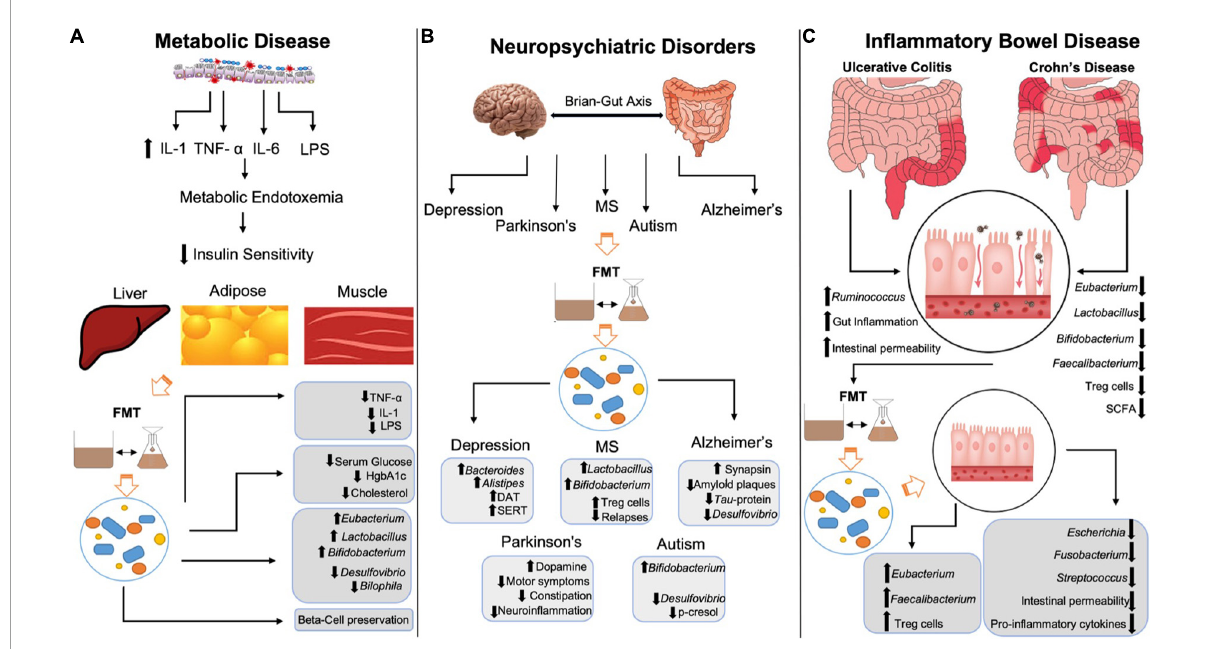
FIGURE1 Mechanisms by which FMT restores negative changes in metabolic disease, neuropsychiatric conditions and inflammatory bowel disease. (A) LPS-mediated increases in IL-1, TNF- α , and IL-6 leads to metabolic endotoxemia decreasing insulin sensitivity in liver, adipose, and muscle tissue. FMT reduces LPS, IL-1 and TNF- α , lowers serum glucose, HgbA1c and cholesterol levels and preserves beta-cells in T1DM patients. FMT increases Eubacterium, Lactobacillus, and Bifidobacterium spp., while reducing Desulfovibrio and Bilophila spp. (B) FMT increases dopamine transporter and serotonin transporter expression, while also increasing Bacteroides and Alistipes in patients in depression. FMT increase Lactobacillus, Bifidobacterium and Treg activity in multiple sclerosis patients, while reducing relapses/flares. FMT increases synapsin, amyloid plaques and Tau-protein phosphorylation in Alzheimer’s disease while reducing Desulfovibrio spp. FMT increases dopamine while decreasing neuroinflammation, motor and non-motor symptoms in Parkinson’s disease. FMT increases Bifidobacterium spp. and reduces p -cresol and Desulfovibrio spp. in autism spectrum disorder. (C) Inflammatory bowel disease is characterized by increased gut inflammation, intestinal permeability and Ruminococcus spp. with decreased Eubacterium, Lactobacillus, Bifidobacterium, Faecalibacterium, Treg activity and SCFA. FMT restores Eubacterium and Faecalibacterium, increases Treg activity, while decreasing Escherichia spp., Fusobacterium, Streptococcus, intestinal permeability, and pro-inflammatory cytokines. IL-1, interleukin-1; TNF- α , tumor necrosis factor α ; IL-6, interleukin-6; LPS,